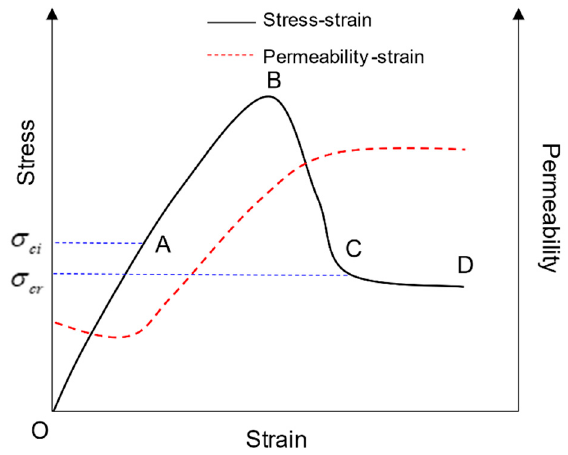
Figure 1. Typical permeability variation curve of mudstone.